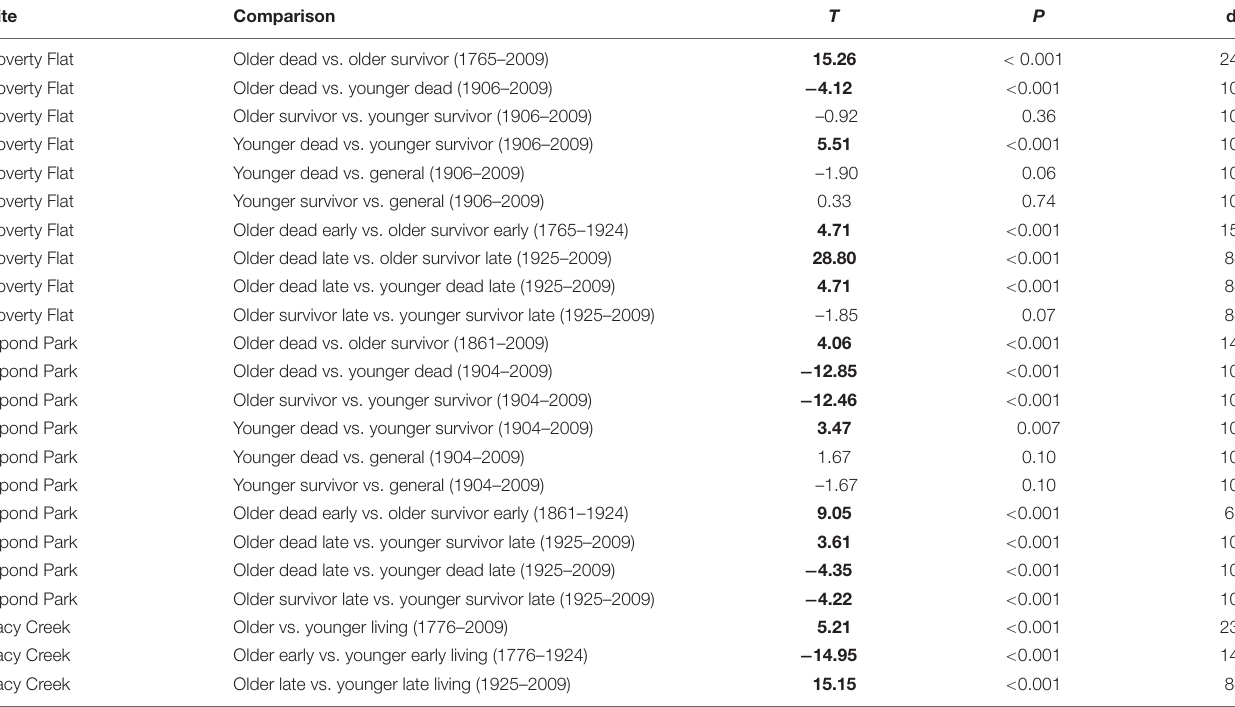
TABLE 6 | Results of paired t -tests conducted using basal area increment (BAI)/basal area (BA) to detect changes in growth that occurred over time in different categories of Pinus albicaulis